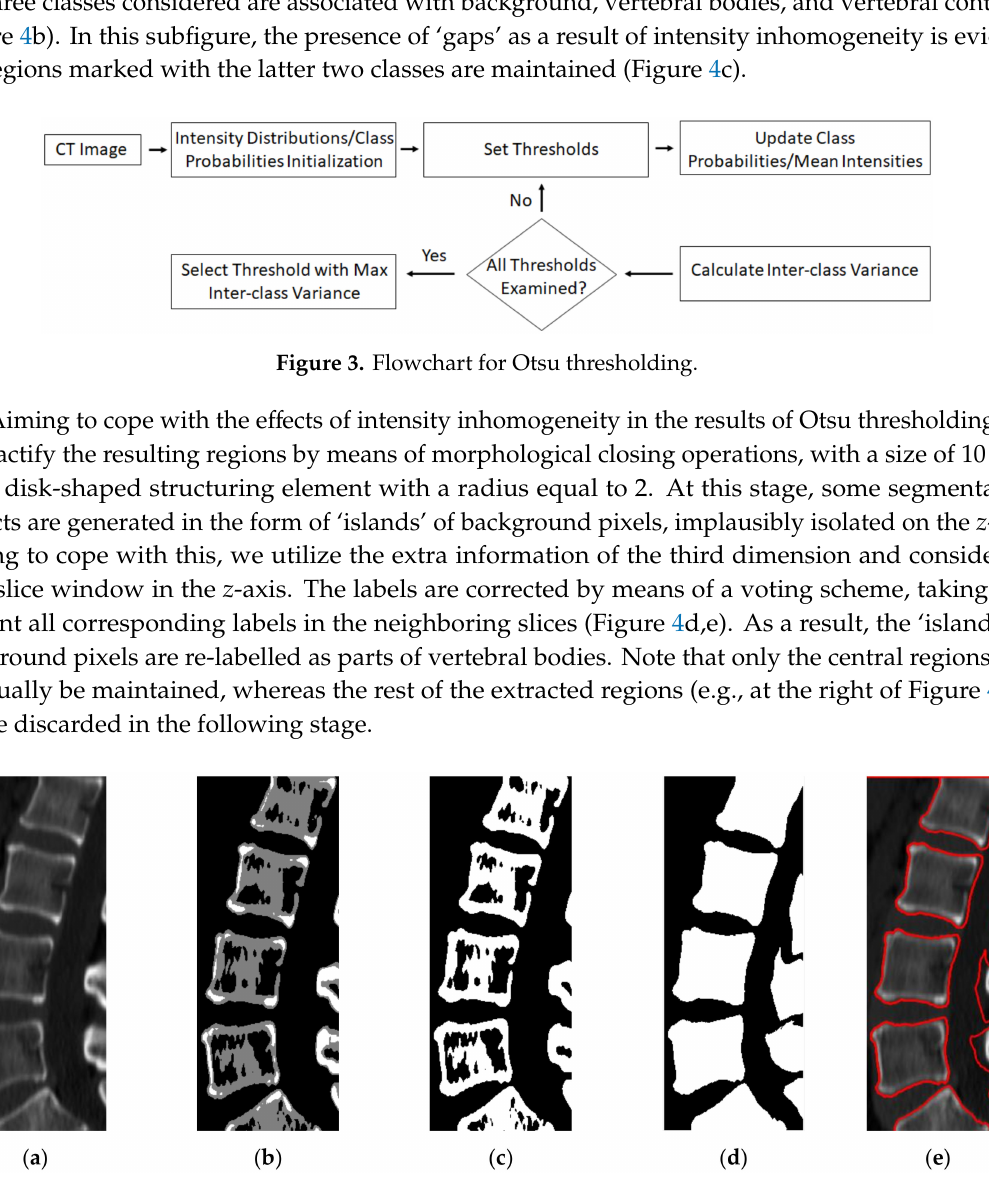
Figure 4. ( a ) Initial CT image, ( b ) Otsu thresholding with three labels, where label ‘1 (cid:48) is assigned to background (black) and labels ‘2,3 (cid:48) are assigned to vertebrae (gray and white pixels), ( c ) binary image, ( d ) resulting image after applying dilation and the inter-slice-based correction, ( e ) boundaries of extracted vertebrae, marked as